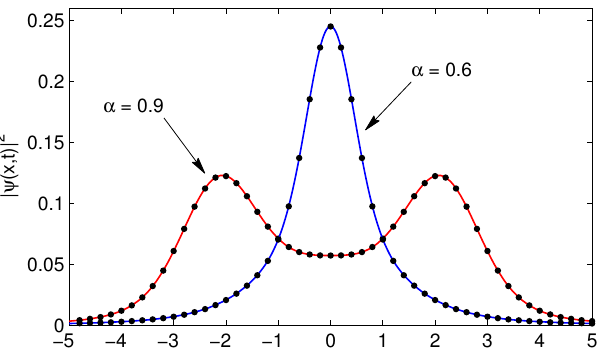
Figure 9. Comparison between the analytical solution Equation ( 69 ) and the matrix approach for the case of the Gaussian initial wave packet Equation (20) with σ =